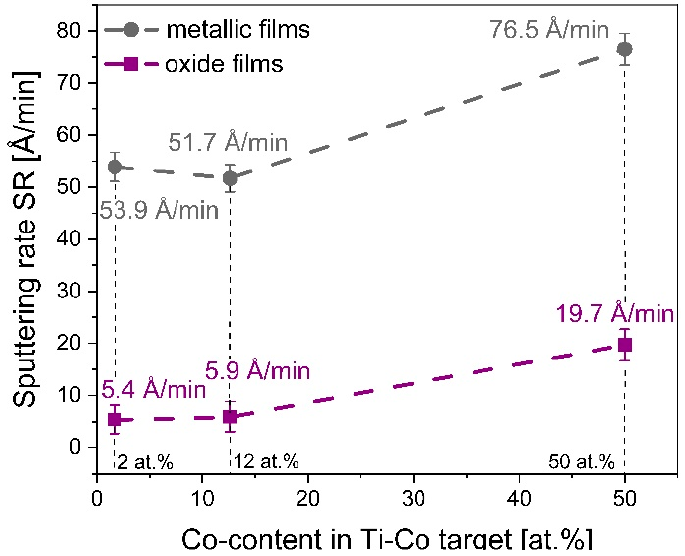
Figure 6. The influence of the Co-content in the Ti–Co target on the sputtering rate (SR) for metallic and oxide thin films.